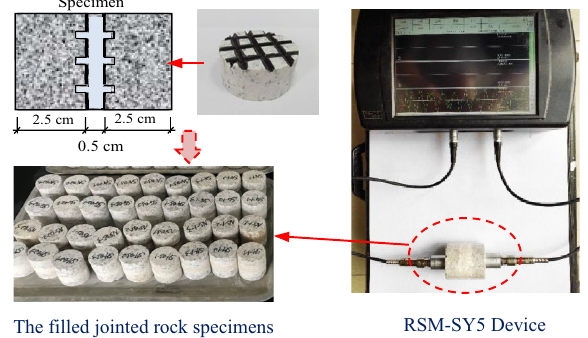
Figure 1. Filled rock joint specimen and wave velocity